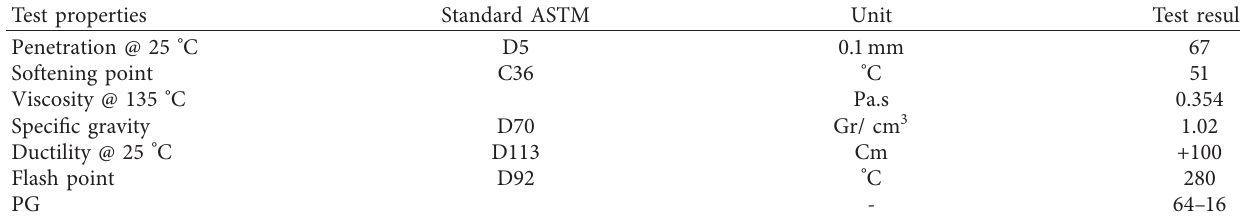
Table 3: The virgin bitumen’s physical characteristics.